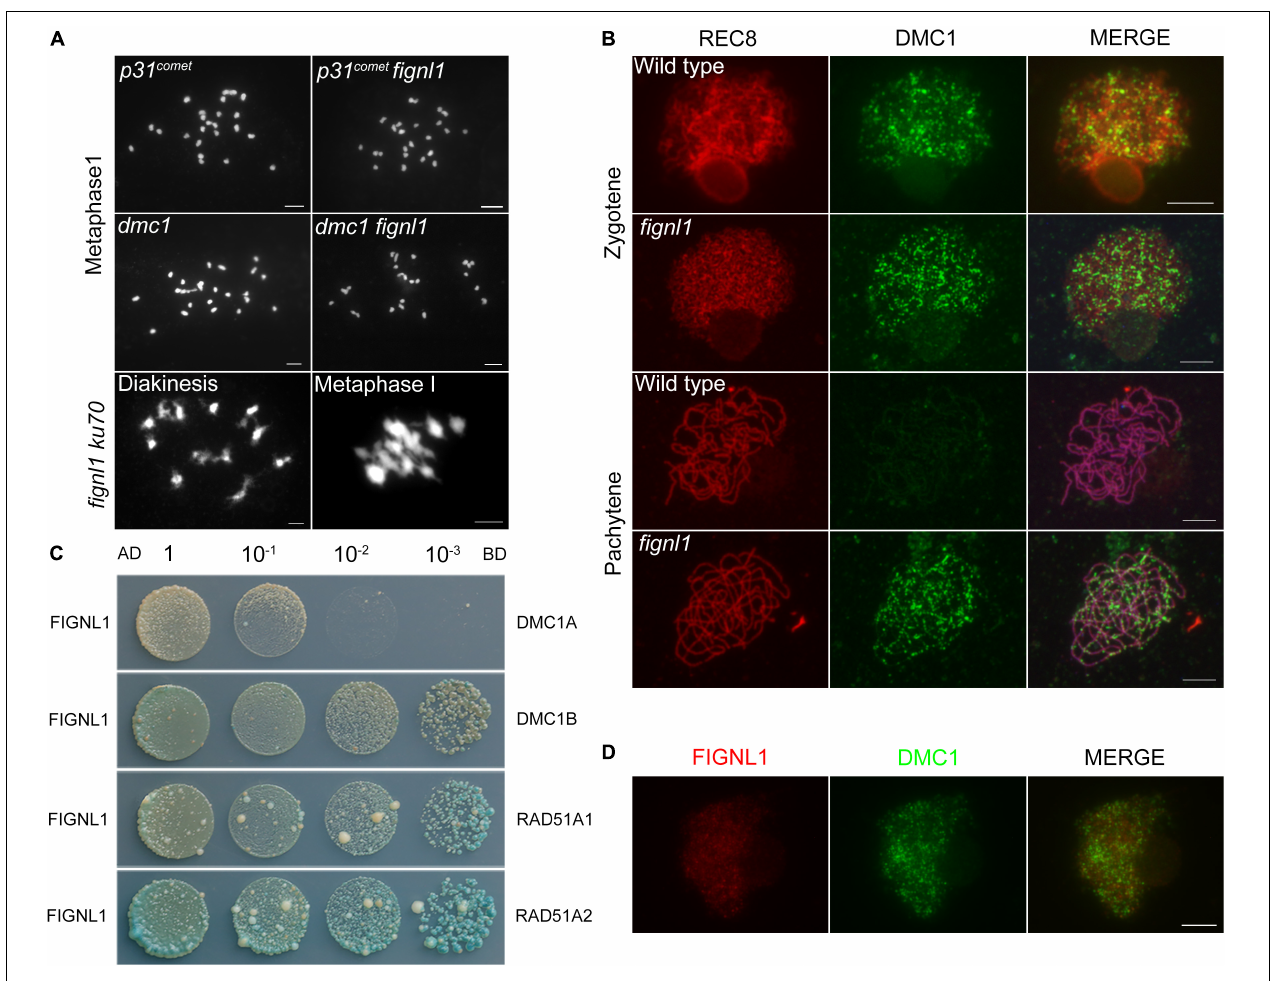
FIGURE 4 | The relationship between FIGNL1 and DMC1. (A) Genetic analysis of FIGNL1 and DMC1. (B) Immunolocalization of REC8 (red) and DMC1 (green) in wild type and fignl1. (C) Examination of the interaction of FIGNL1 with RAD51A1, RAD51A2, DMC1A, and DMC1B by yeast two-hybrid assay. AD, prey vector; BD, bait vector. (D) Immunolocalization of FIGNL1 (red) and DMC1 (green) in wild type. Scale bars, 5 µ